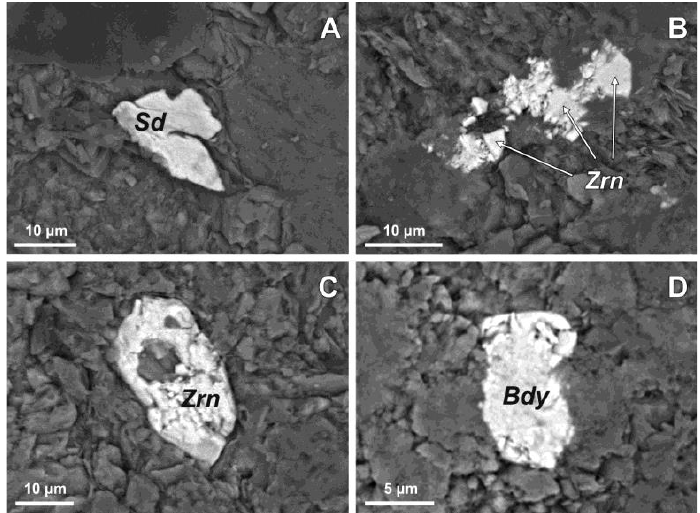
Figure 7. Occurrence of euhedral siderite ( A ), micro-aggregate ( B ) and larger euhedral crystal ( C ) of zircon, and euhedral baddeleyite ( D ) in black shale from the Priorat DOQ region. Sd — siderite, Zrn — zircon, Bdy — baddeleyite.